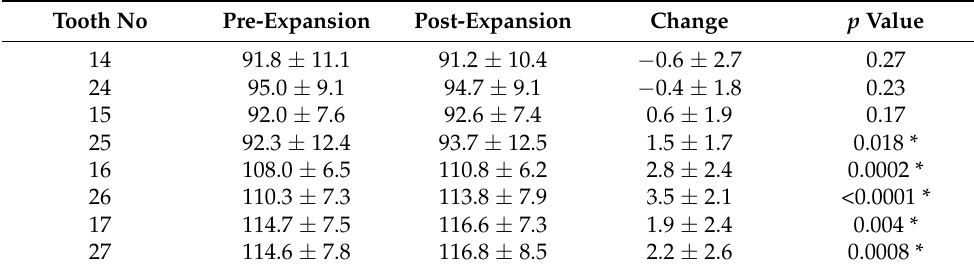
Table 1. Mean and SD of pre- and post-expansion tooth inclination and inclination change (in degrees). A positive Mean change indicates a buccal inclination, a negative mean change indicates a palatal inclination. The p -values of the comparison with the zero change are tabulated. The asterisk indicates statistical significance.